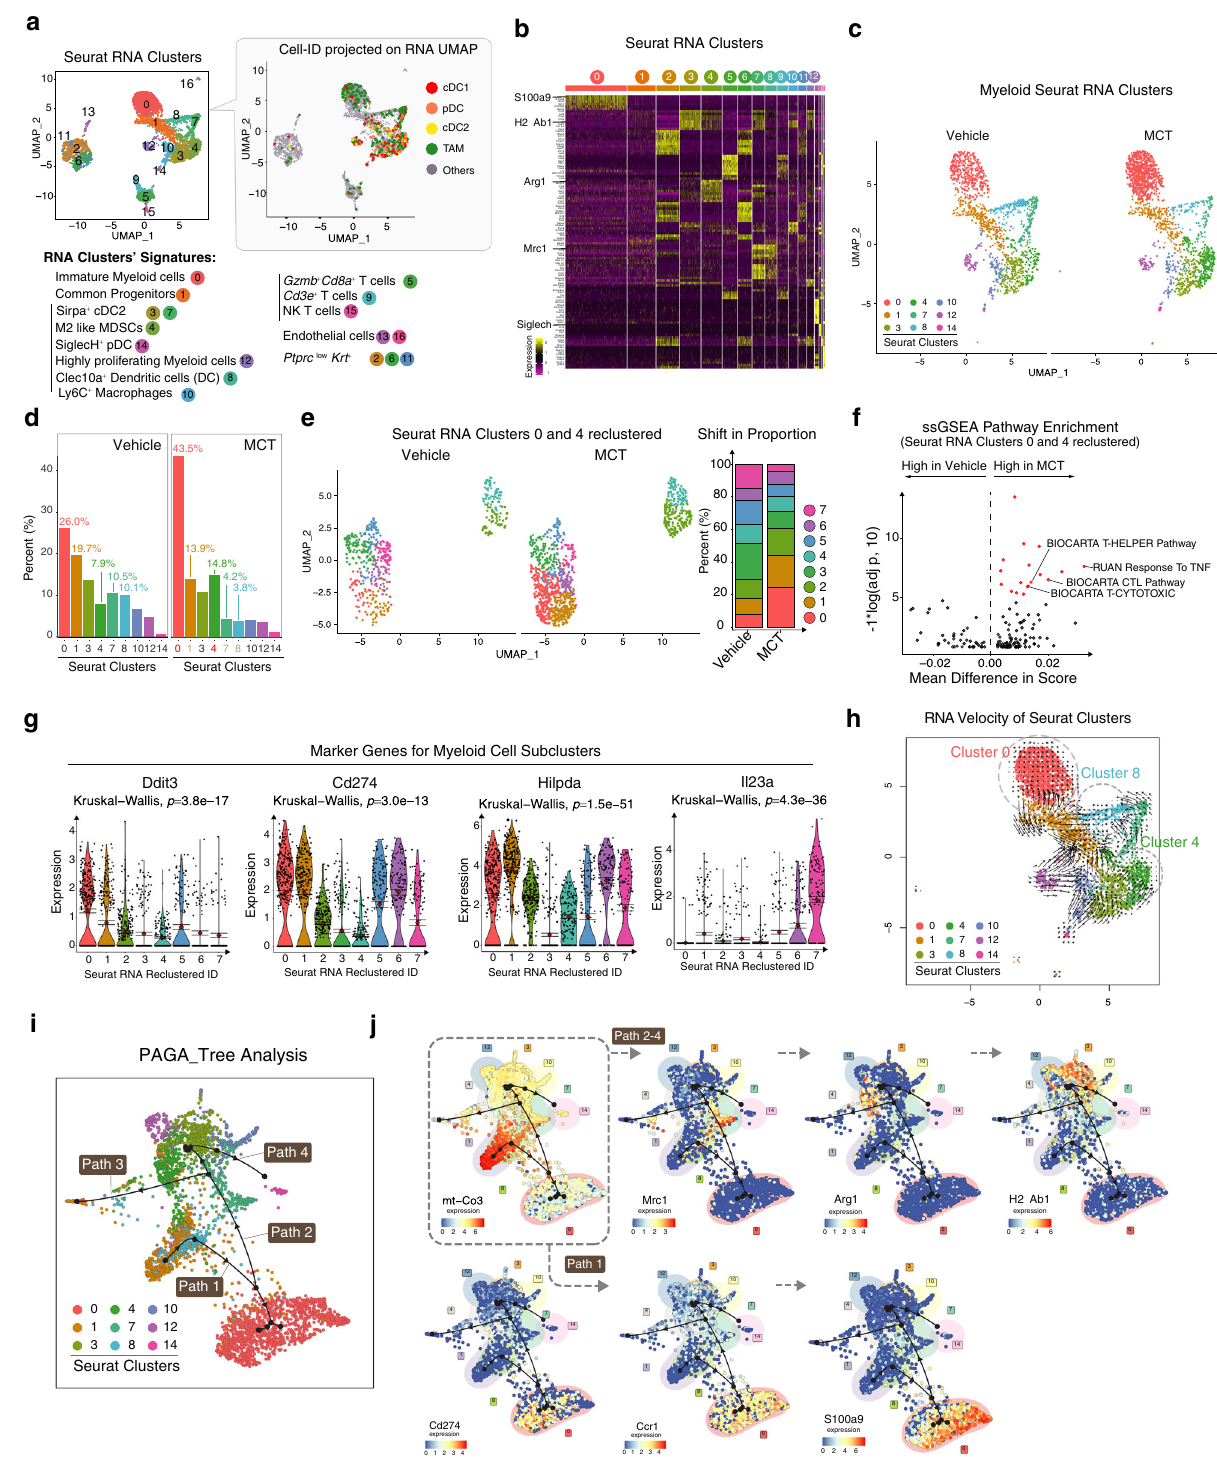
Fig. 2 | CITE-seq reveals distinct myeloid subsets co-exist in MCT-treated TME. a UMAPclustersofTNBCderivedsinglecells:RNAde fi nedclusters(left)andCell-ID de fi nedclustersofTADCsandTAMs(right)(inboththeUMAPs:dots=cells,Cell-ID UMAP:coloreddots=TADsandTAMs,andgraydots=nonTADCsandnonTAMs). b Heatmap shows expression of top differentially expressed genes (DEGs) among RNA Seurat Clusters. c UMAP clusters of transcriptionally de fi ned myeloid cells split by treatment. d Bar plot shows (%) proportion of myeloid Seurat Clusters projectedin c . e UMAP(left)splitbytreatmentprojectsreclusteredSeuratClusters 0and4.Stackedbarplot(right)showsshiftsintheproportionofdifferentclusters